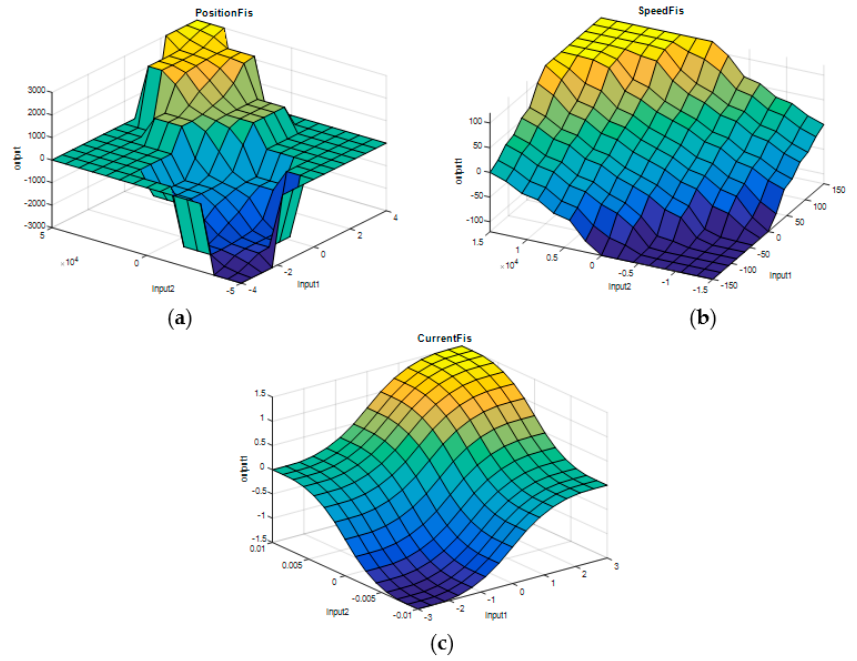
Figure 12. The fuzzy control surfaces for the three FISs: ( a ) PositionFIS, ( b ) SpeedFIS, and ( c ) CurrentFIS.